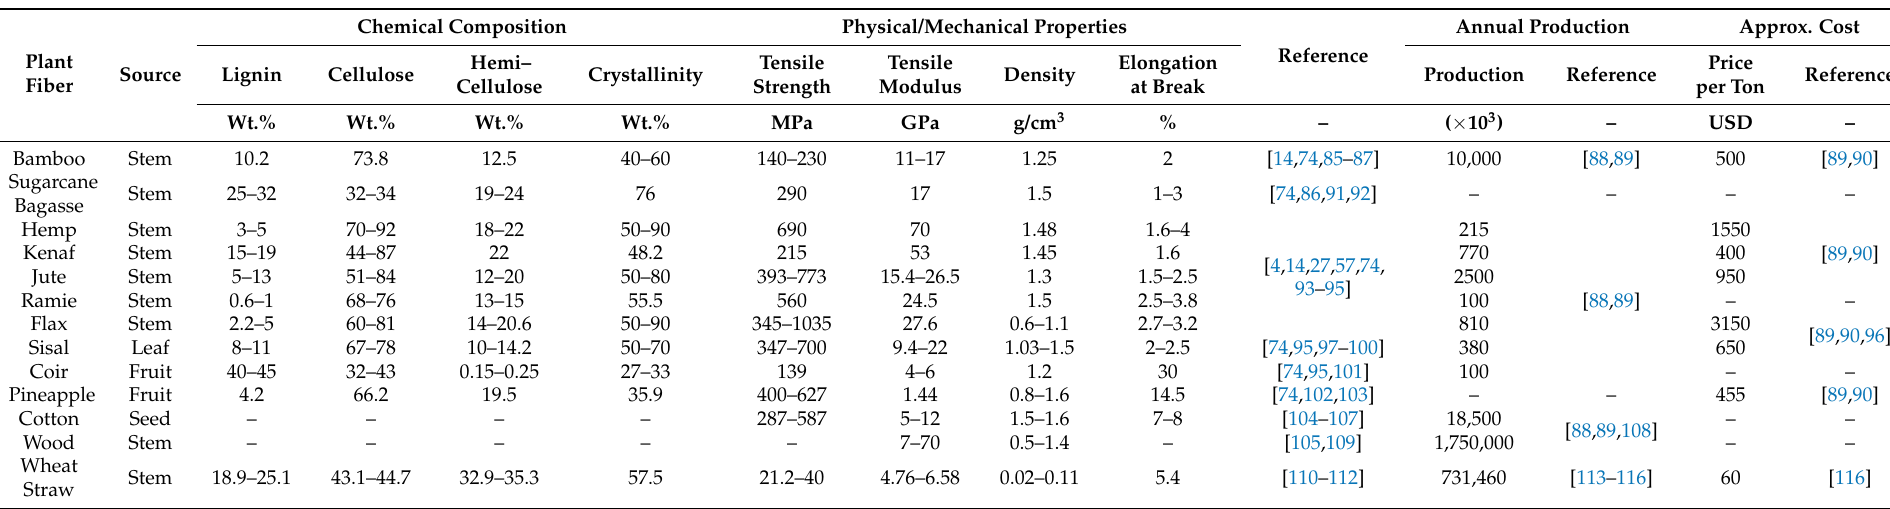
Table 1. Reviews of the chemical/physical/mechanical properties, chemical treatments, annual production, and approximate cost of plant